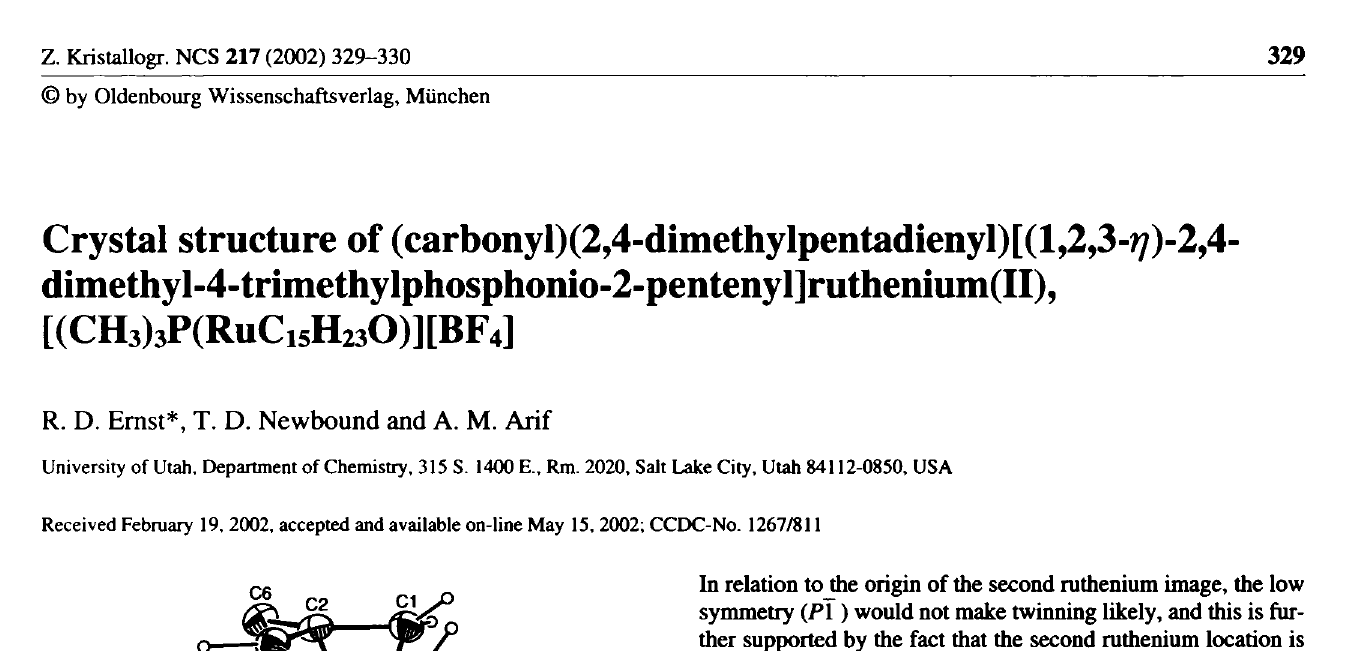
Table 1. Data collection and handling. Crystal: